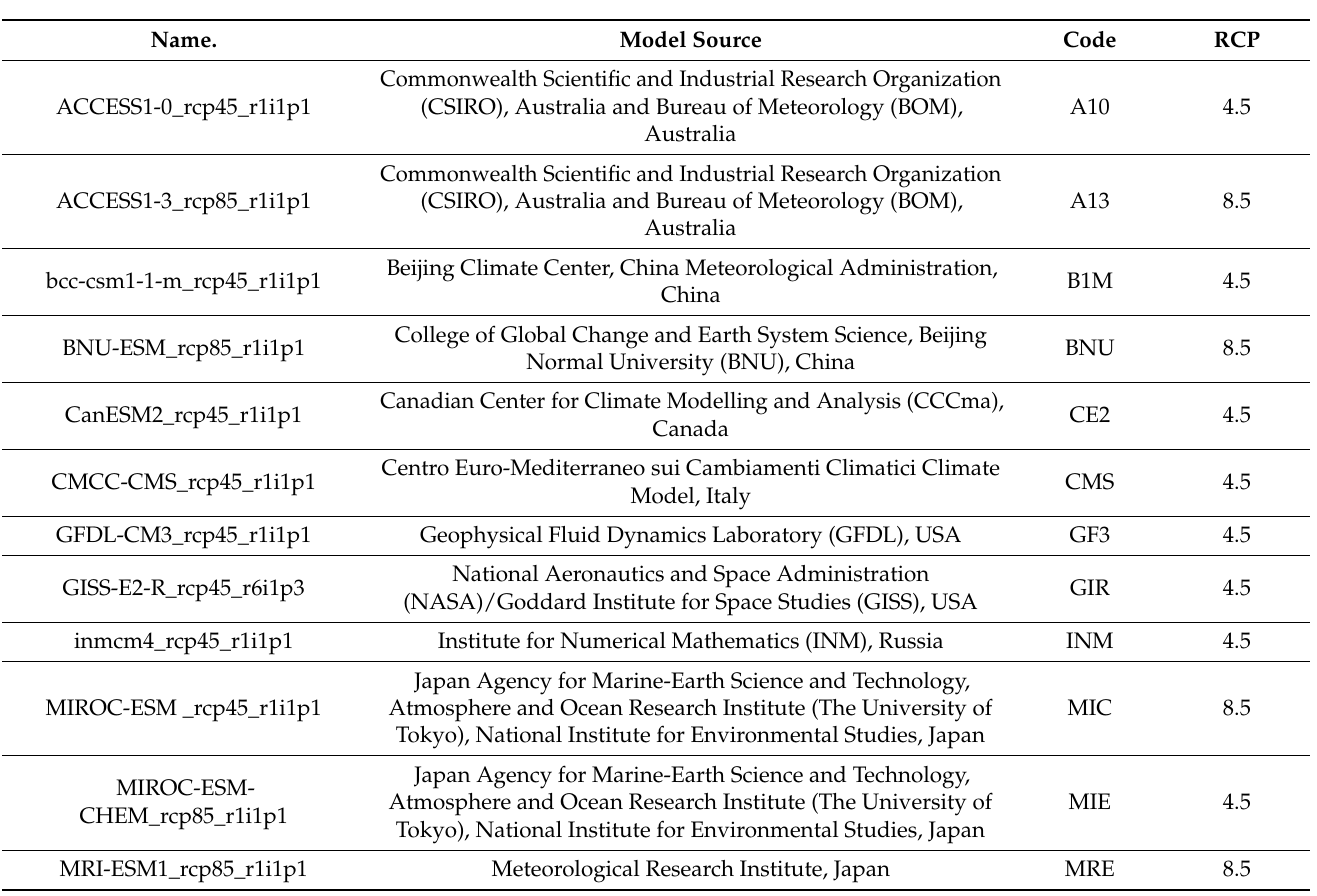
Table 3. Selected climate